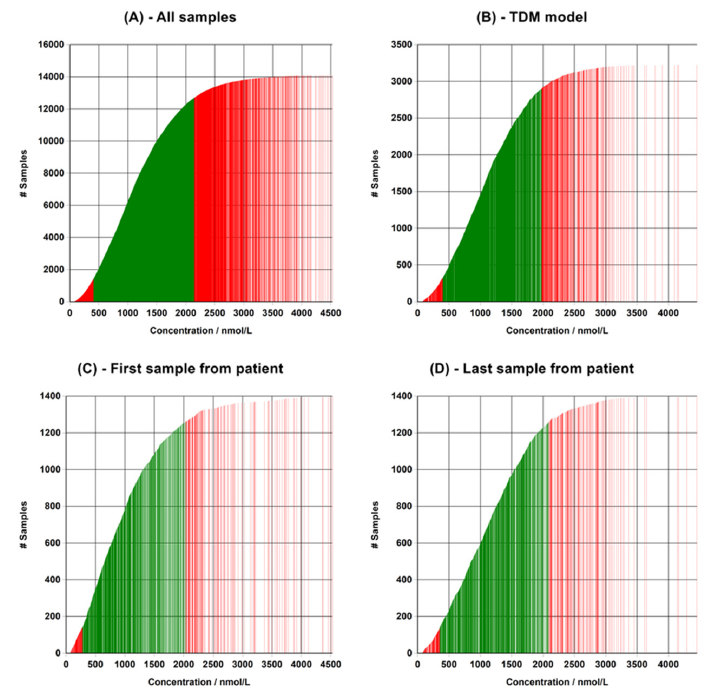
Figure 3. Evaluation of the described TDM model for selecting results from retrospective laboratory data sets. Graphs shows percentile plots for clozapine as examples, where each line represents a sample result. ( A ) All samples in the data set, ( B ) samples selected using the TDM model, ( C ) only the first result from a patient is used, and ( D ) only the last result from a patient is used. The 10–90% percentile is marked in green. The graphs were generated and exported by using the RefIT software.